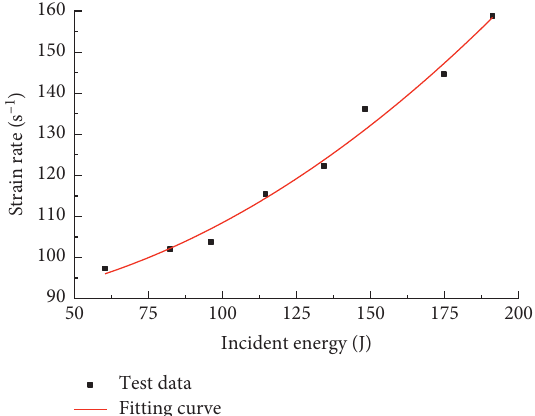
Figure 16: Relationship between strain rate and incident energy.